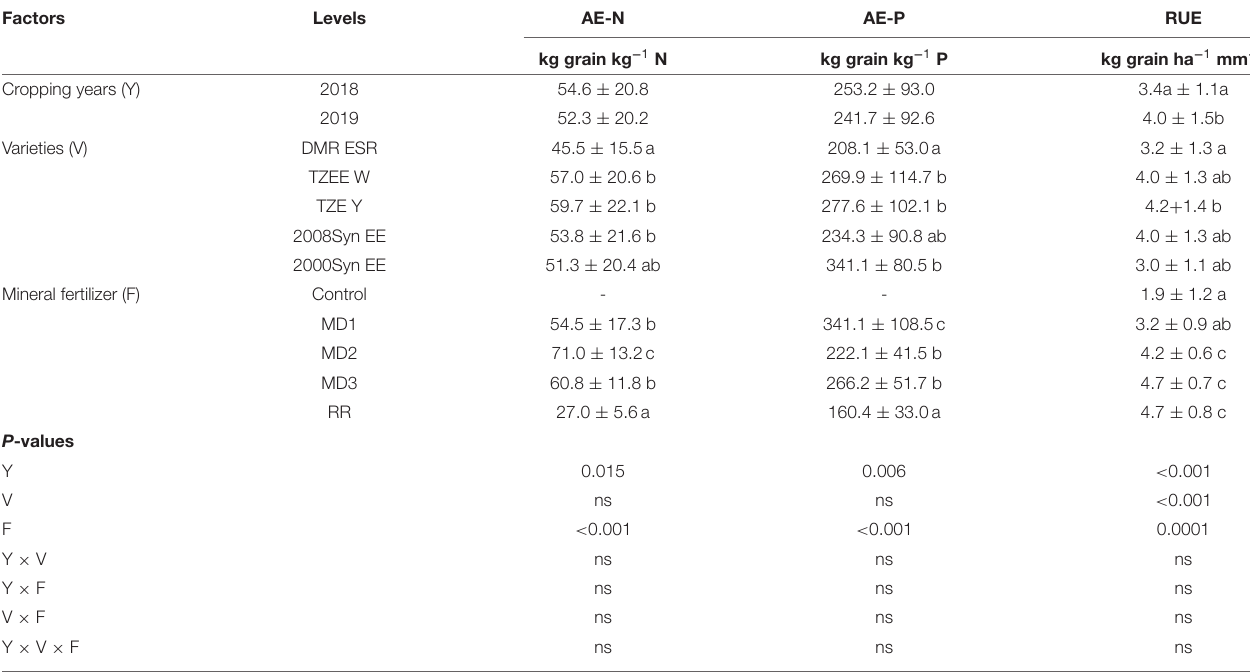
TABLE 4 | Agronomic efficiency of N (AE-N) and P (AE-P) and rainfall use efficiency (RUE) (mean ± standard error) as affected by the cropping years, varieties, and mineral fertilizer.